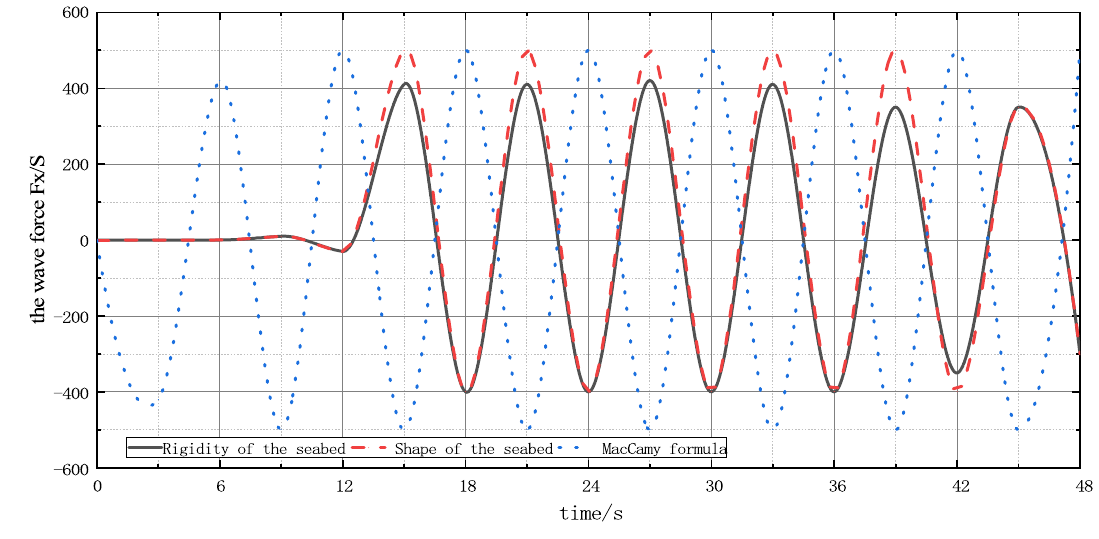
Fig. 4 Time history curve of wave force FX on a single pile